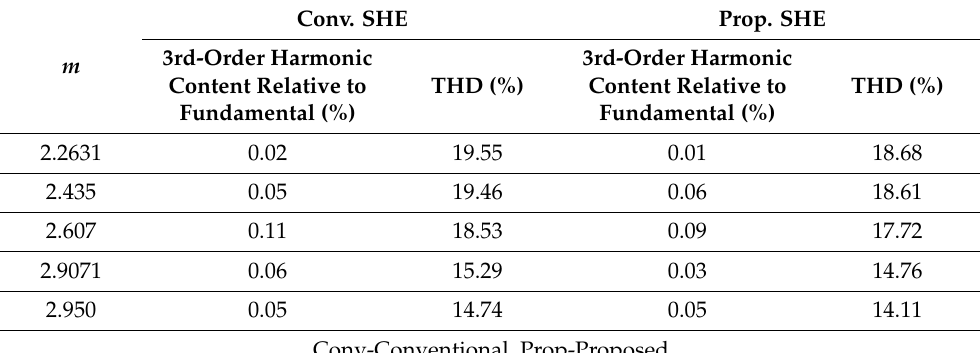
Table 2. Simulation results for 5th order harmonic elimination.